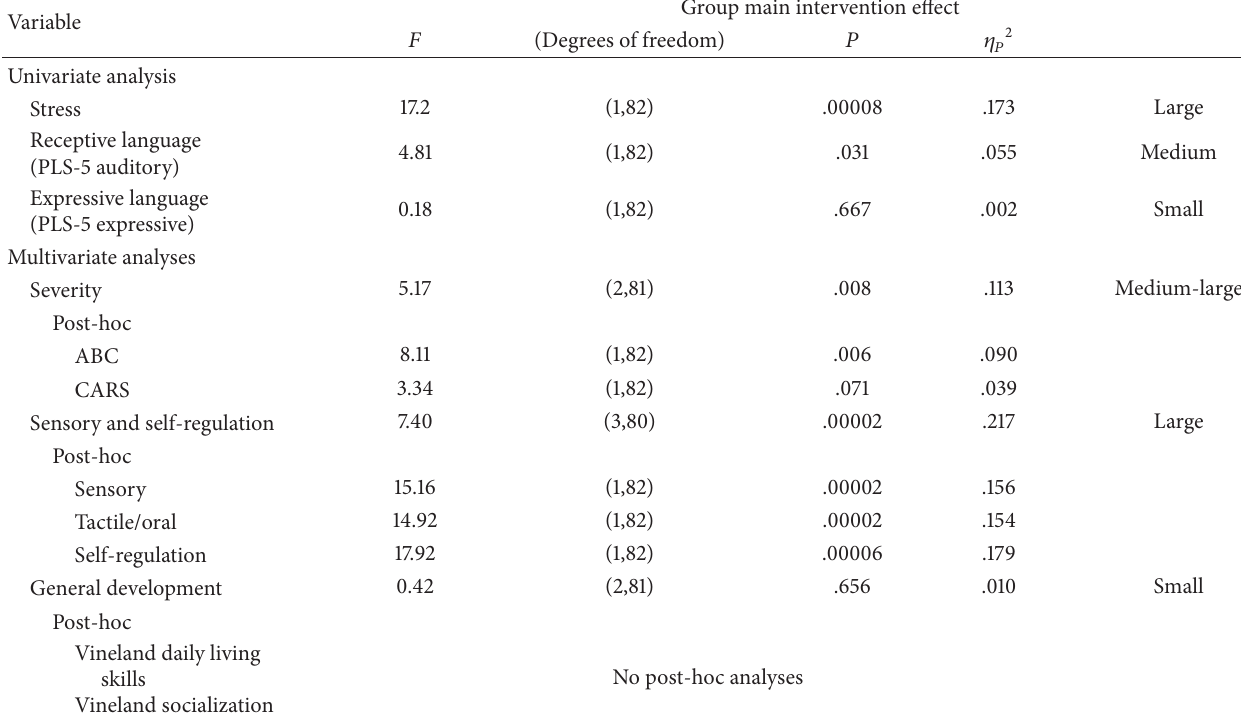
Table 4: Treatment effects for QST massage (repeated measures